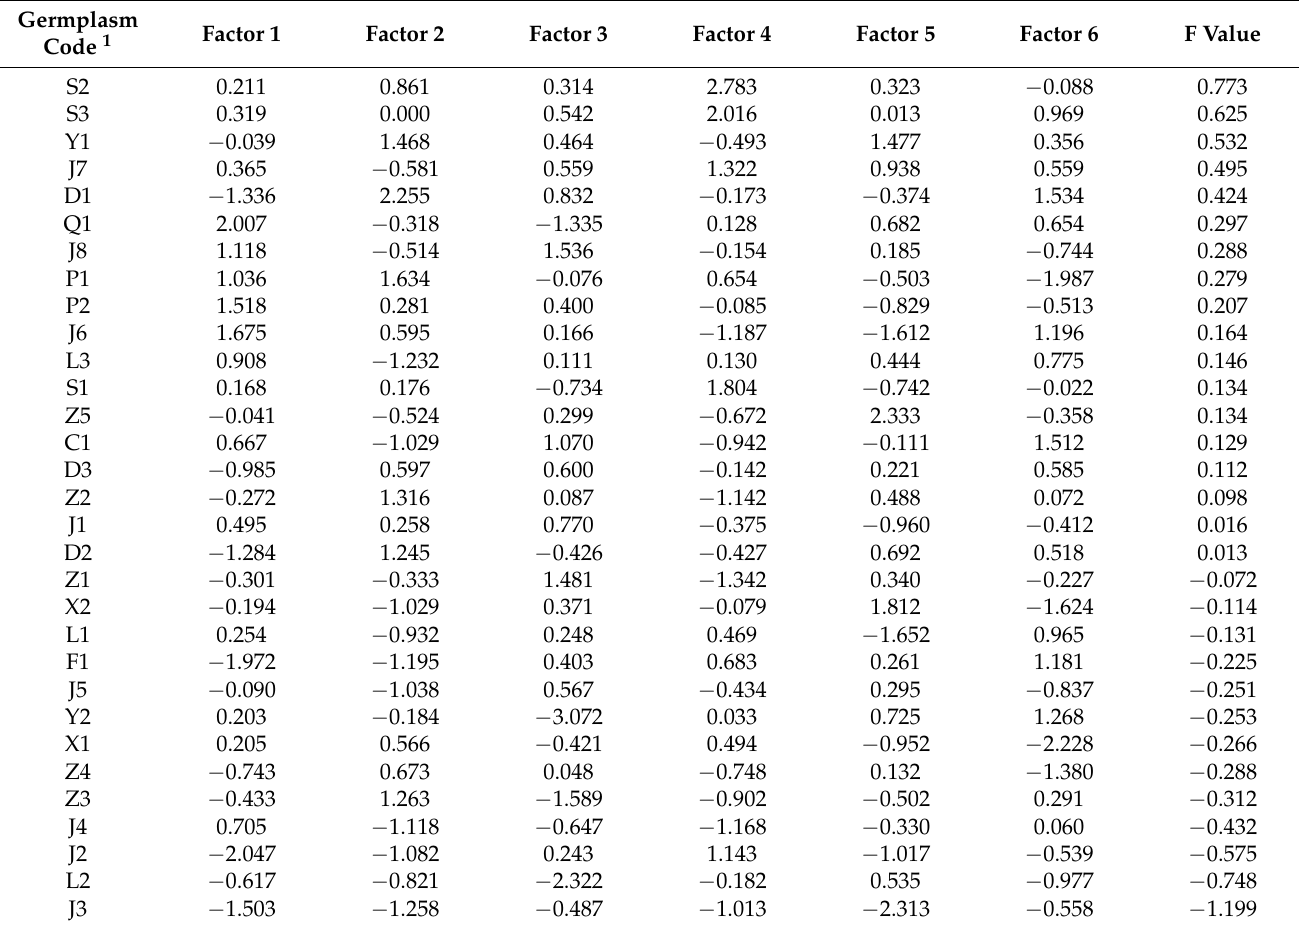
Table 6. Comprehensive score of H. acerba